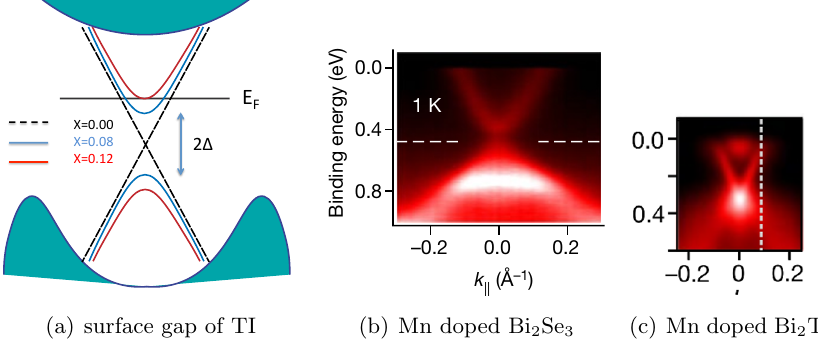
Figure 1 . (a) Evolution of density of state as the doping changes. As we increase the doping the Figure 1 . surface gap increases, and the fermi surface gets smaller. At some point, the surface band touches FS and the system become strongly interacting. The green colored region represent the the bulk bands and the lines are for surface bands. The (cid:12)gure is from [44]. (b,c) The actual ARPES